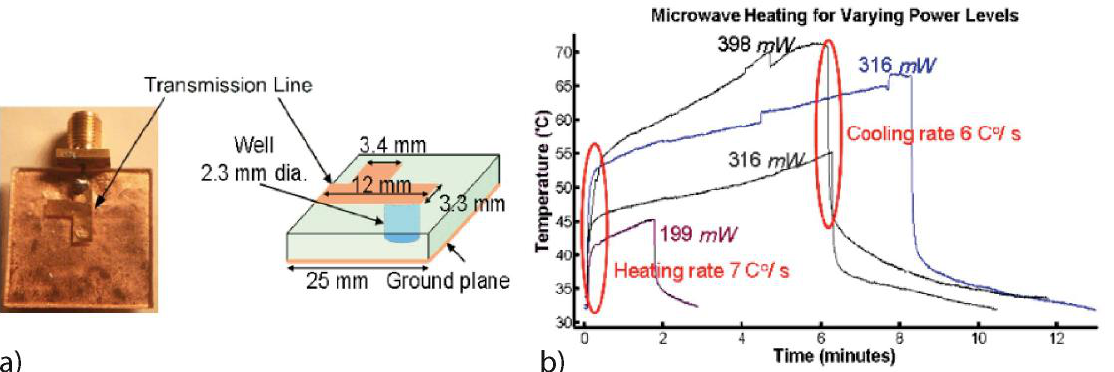
Figure 26. ( a ) Device schematic. ( b ) Temperature versus time for varying power levels. Reprinted with permission from [56]. Copyright 2009, American Institute of